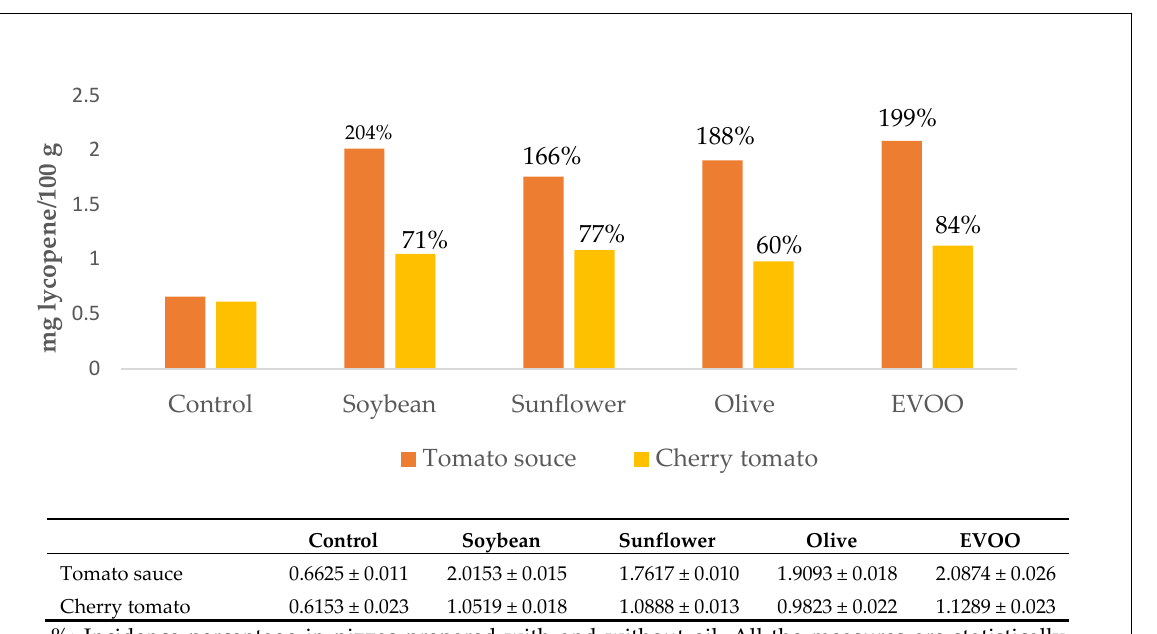
Figure 3. Amount of lycopene expressed as mg/100 g of pizza measured on lipophilic extracts as a function of the type of oil used.